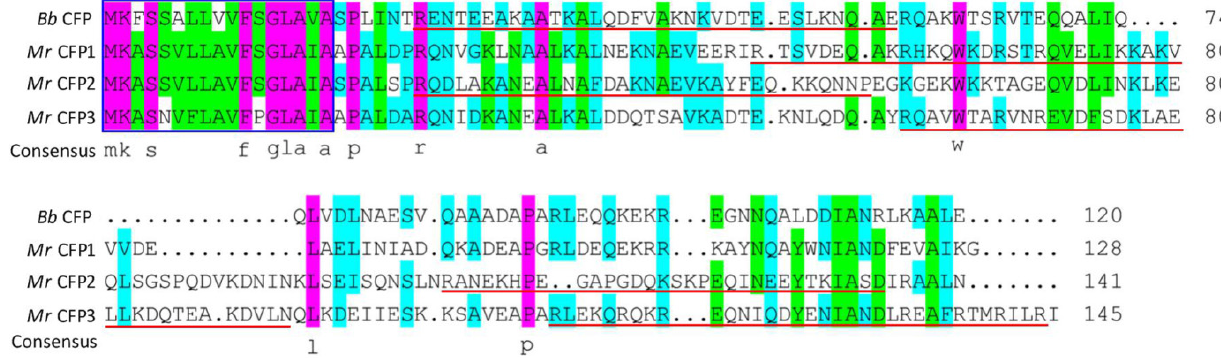
Figure 1. Sequence comparisons of three M. robertsii ( Mr ) CFP homologs (CFP1–3) with unique B. bassiana ( Bb ) CFP. Amino acid sequences were aligned at http://www.bio ‐ soft.net/format/DNA MAN.htm (accessed on 4 June 2022). N ‐ terminal signal peptide (in blue rectangle) and NLS motif (underlined) were predicted from each sequence at http://www.cbs.dtu.dk/services/SignalP ‐ 4.1 (ac ‐